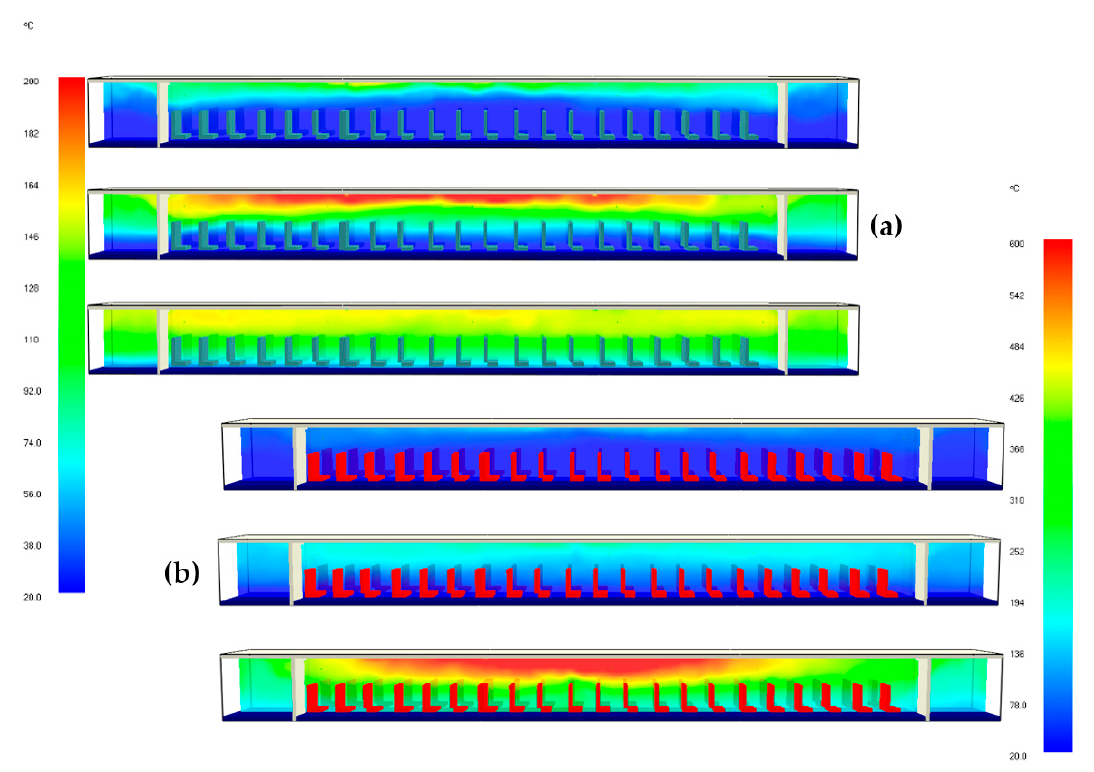
Figure 15. Temperature variations along the central plane of carriage after 40 s, 80 s and 120 s for ( a ) PN6 model and ( b ) PLY model.